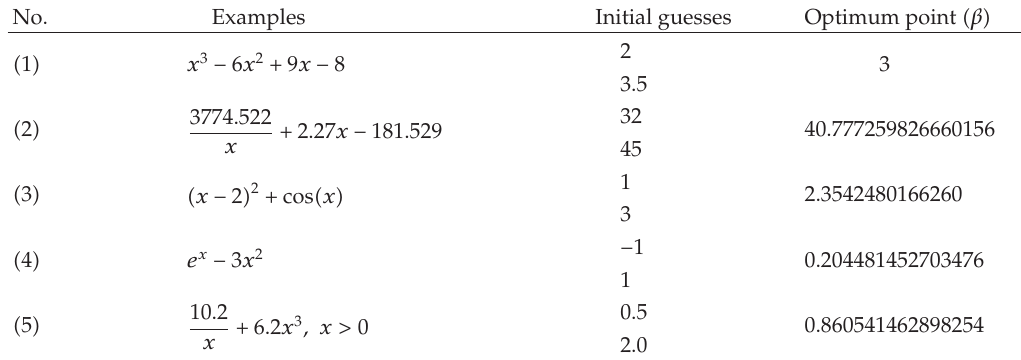
Table 3: Unconstrained optimization problems.